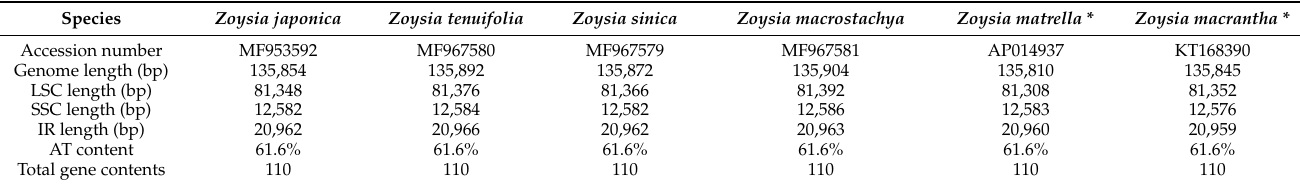
Table 1. The comparative feature of six Zoysia